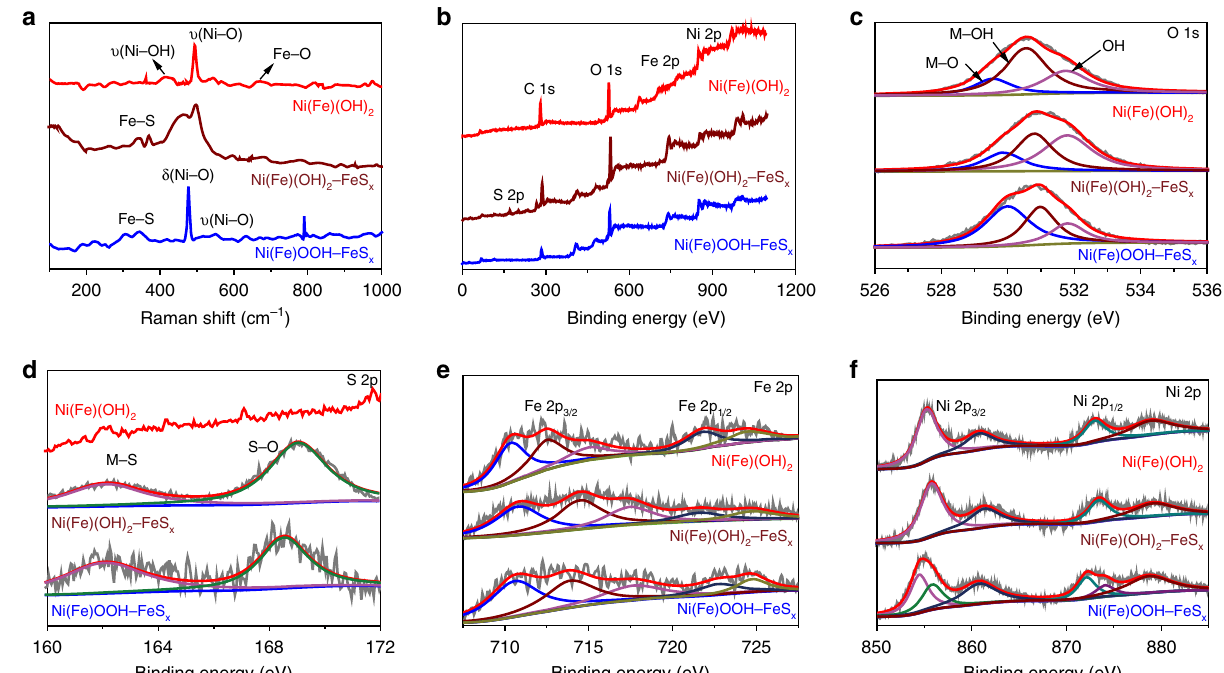
Fig. 3 Compositional characterizations of different corrosion-formed products. a Raman spectra, b XPS surveys, c – f high-resolution XPS spectra of O 1 s ( c ), S 2 p ( d ), Fe 2 p ( e ) and Ni 2 p ( f